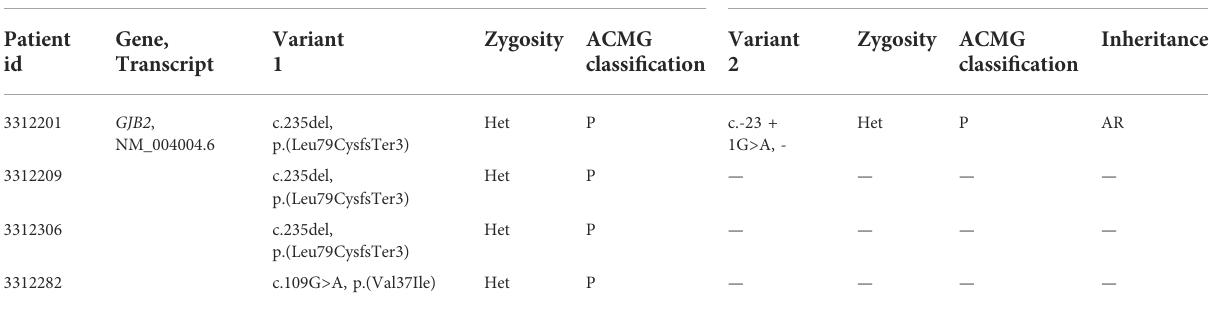
TABLE 3 GJB2 c.-23 + 1G > A varaint in one patient (single heterozygous). GJB2 exon 2